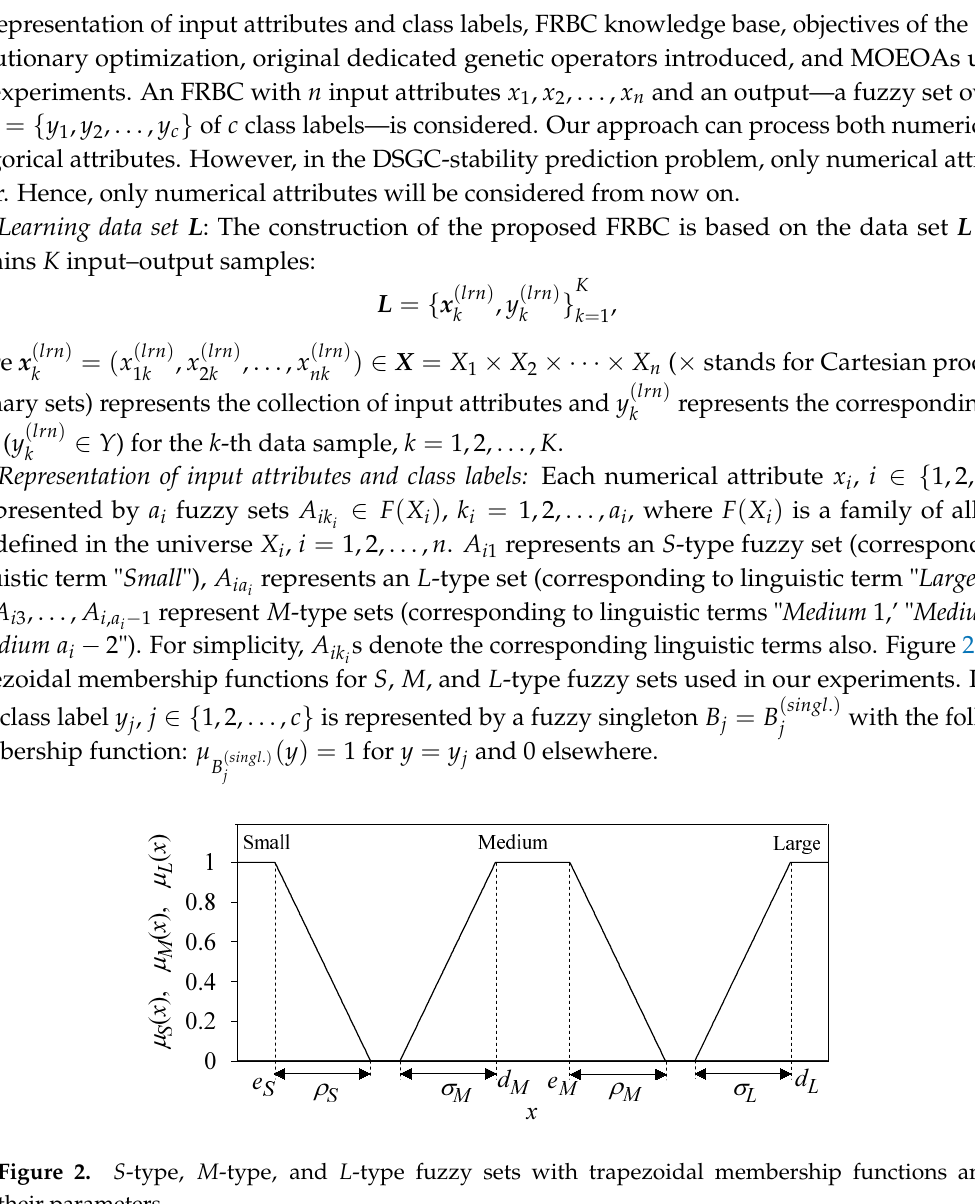
Figure 2. S -type, M -type, and L -type fuzzy sets with trapezoidal membership functions and their